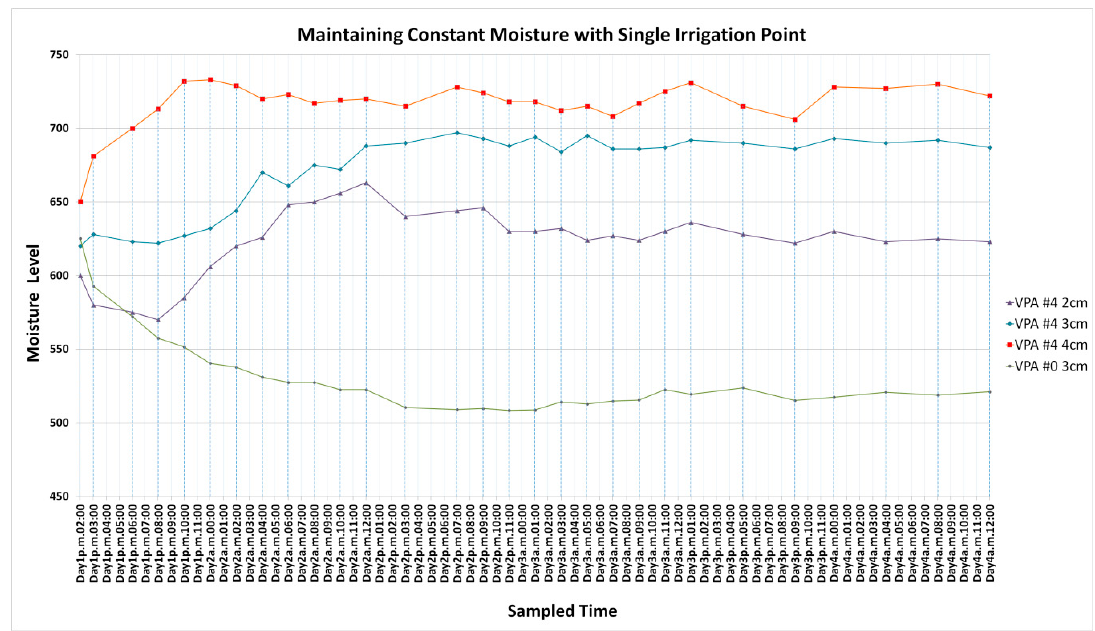
Figure 9. The constant moisture experiment with a single irrigation point. The moisture levels of VPA#4 with different depth layers of soil are sampled. The VPA#0 3 cm, which is the neighboring VPA, is also evaluated. The moisture level is ranged from 0 to 1023.